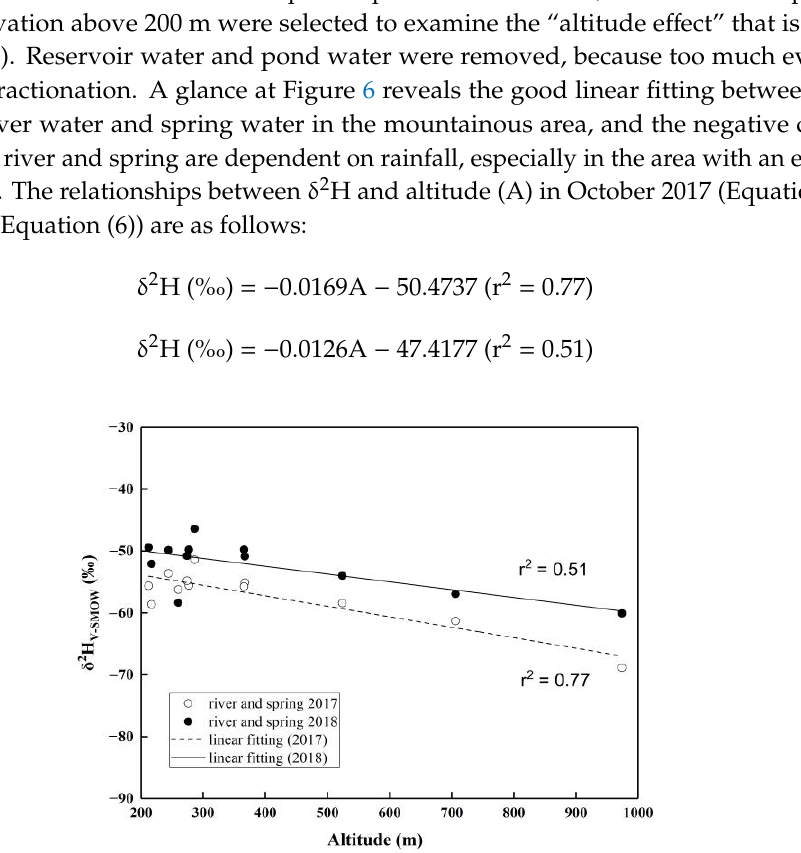
Figure 5. Spatial distribution of δ 2 H values in the Upper Pi River basin in ( a ) 2017 and ( b ) 2018.